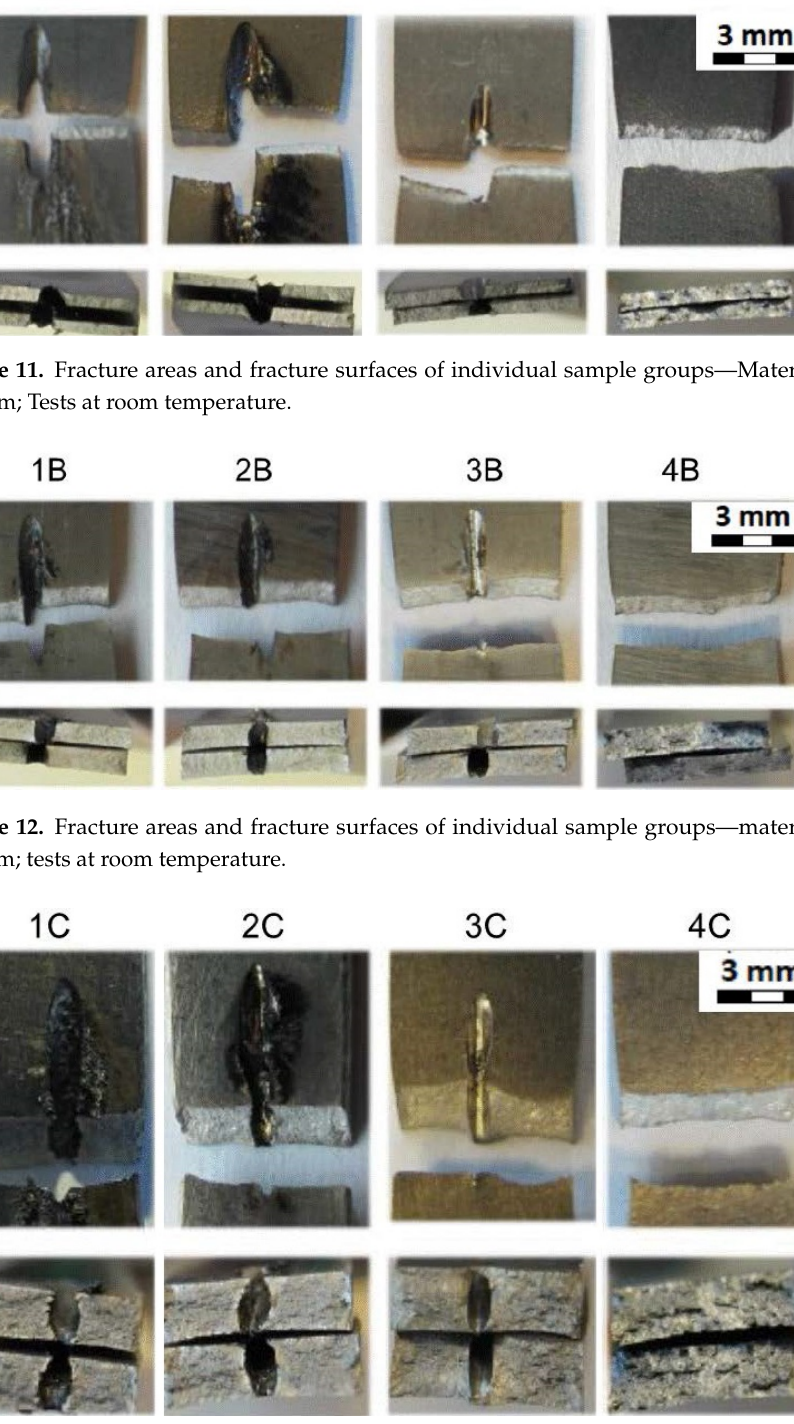
Figure 13. Fracture areas and fracture surfaces of individual sample groups—material thickness 1.6 mm; tests at room temperature.